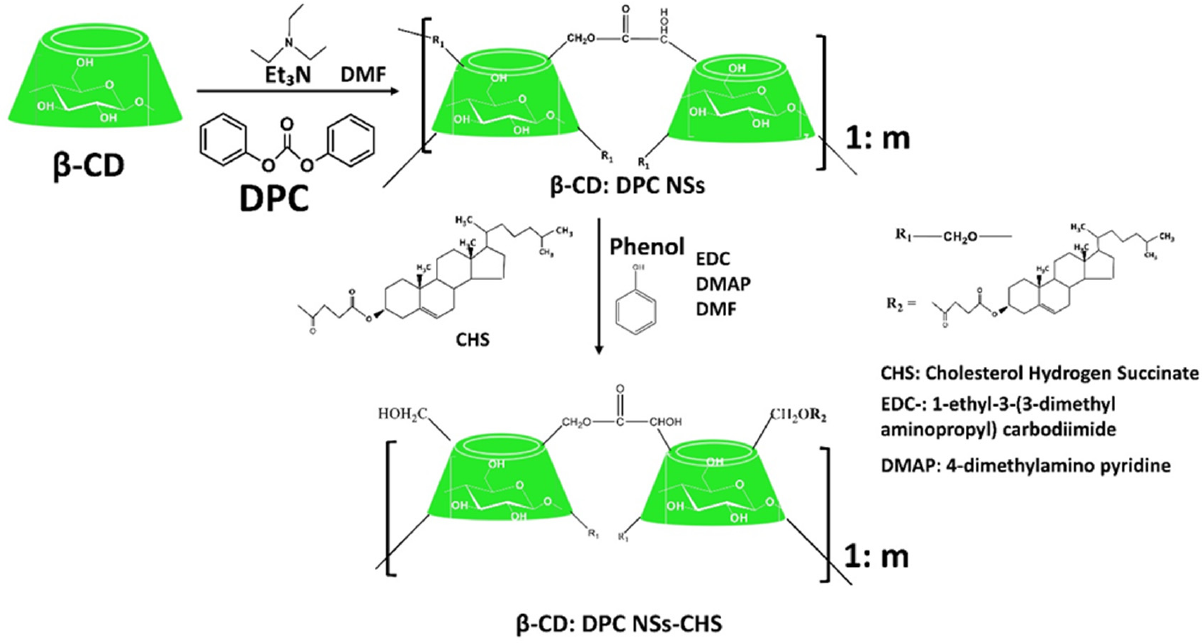
Figure 13. The cholesterol hydrogen succinate (CHS) grafting, in CD-based carbonate NSs ( β -CD:DPC NSs), using coupling reaction.